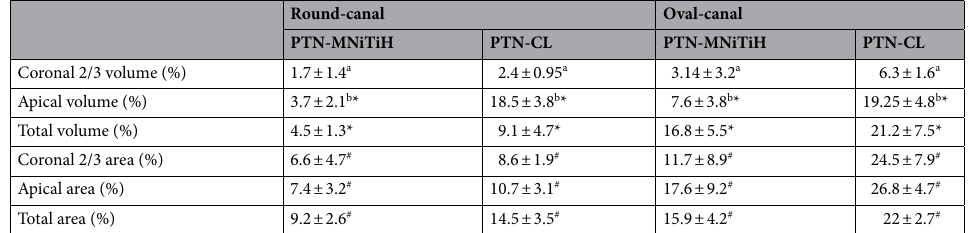
Table 2. Mean Percentage of Volume (mean ± standard deviation) and of Covered Canal Surface Area of RFMs in different instrument groups. Different superscript lowercase letters indicate a significant difference considering each group in the three-thirds of the teeth (independent-samples t test, P < 0.05). *indicates a significant difference between different instrument groups of the volume of RFMs (independent-samples t test, P < 0.05). # indicates a significant difference ( P < 0.05) between different instrument groups of the covered canal surface area of RFMs (independent-samples t test, P <